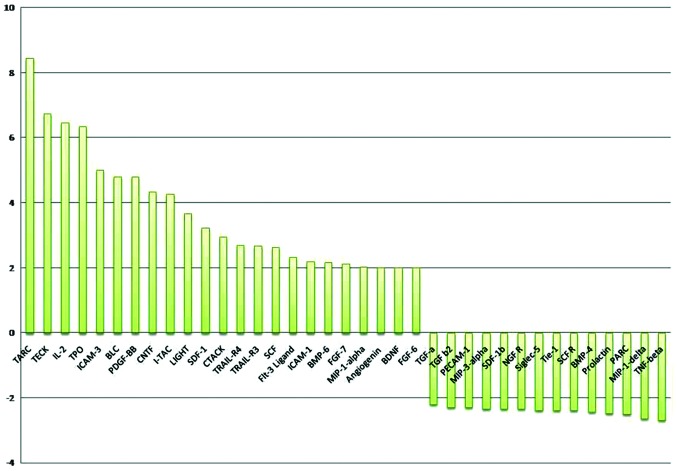

The effect of aPC on the ovarian cancer cell line. In order to analyze the pleiotropic role of active protein C (after treatments of ovarian cell line with aPC for 24 h), we examined the cell supernatants using a protein cytokine array as described in Materials and methods (RayBio

®

Human Cytokine Antibody). The ratio of values between cells treated by aPC and non-treated is shown. The positive control was considered as 1. Of the 174 proteins proposed in this test only 23 were upregulated (ratio of cells treated by aPC vs. non-treated cells was >2). They are TARC, TEK, IL-2, TPO, ICAM-3, BLC, PDGF-BB, CNTF, I-TAC, LIGHT, SDF-1α, CTACK, TRAIL-R3, SCF, FLT-3 ligand, ICAM-1, BMP-6, FGF-7, MIP-1α, angiogenin, BDNF and FGF-6 while 14 proteins such as TGFα, TGFβ, PECAM-1, MIP-3α, SDF-1β, NGF-R, Siglec-5, BMP-4, prolactin, PARC, MIP-1δ and TNFβ were downregulated (ratio cells treated by aPC vs. non-treated cells was <2). The ratio situated beyond 4 was taken into consideration for the present study. The results indicate that aPC interacted with tumor cells and activated the secretion of several cytokines such as thymus and activation-regulated chemokine (TARC, CCL17), thymus expressed chemokine (TECK, CCL25), interleukin-2 (IL-2), thrombopoietin (TPO), intercellular adhesion molecule-3 (ICAM-3, CD56), B lymphocyte chemoattractant (BLC), platelet-derived growth factor-BB (PDGF-BB), ciliary neurotrophic factor (CNTF) and T cell alpha chemoattractant (I-TAC) by ovarian cell lines.